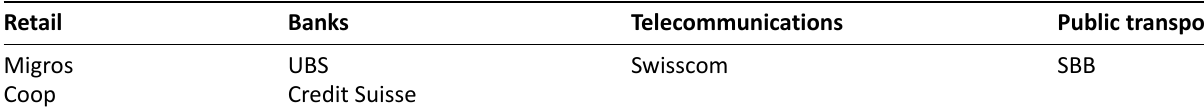
Table 1. Sample of most important advertisers.